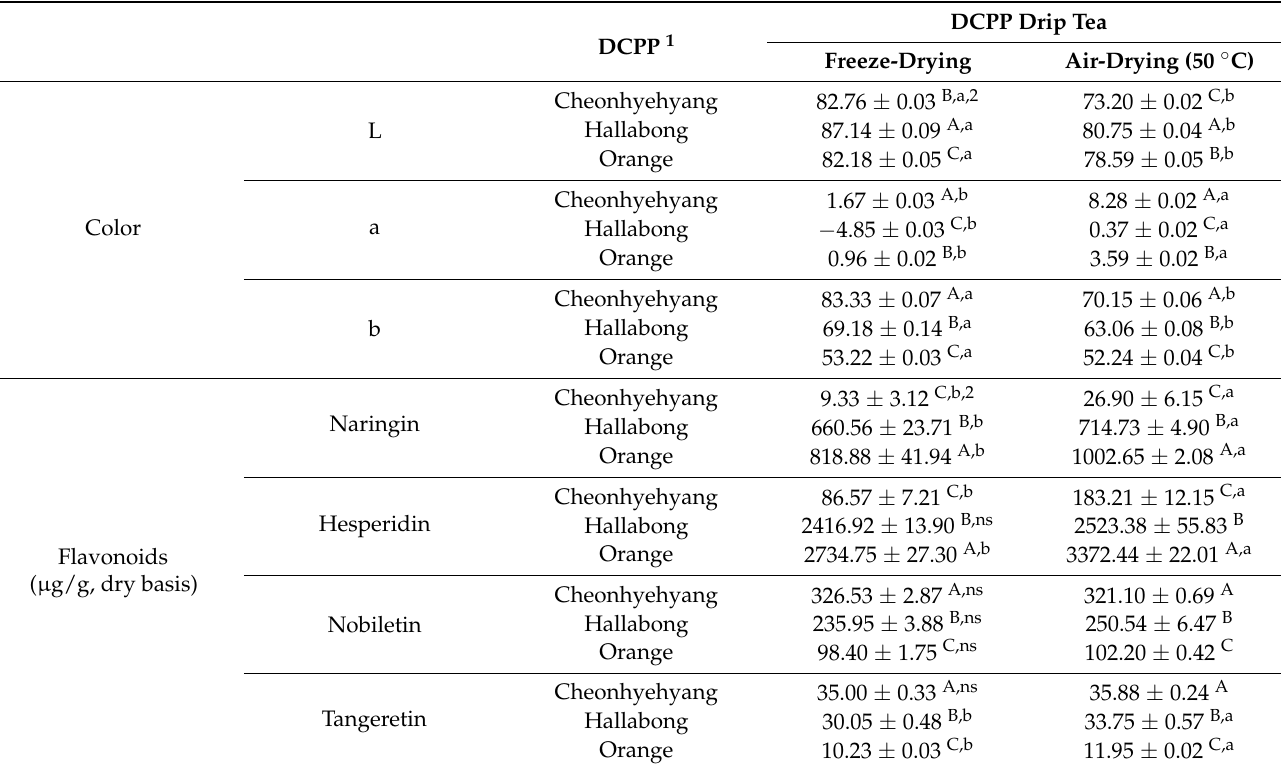
Table 1. Color and flavonoid contents of DCPPs prepared by freeze- and